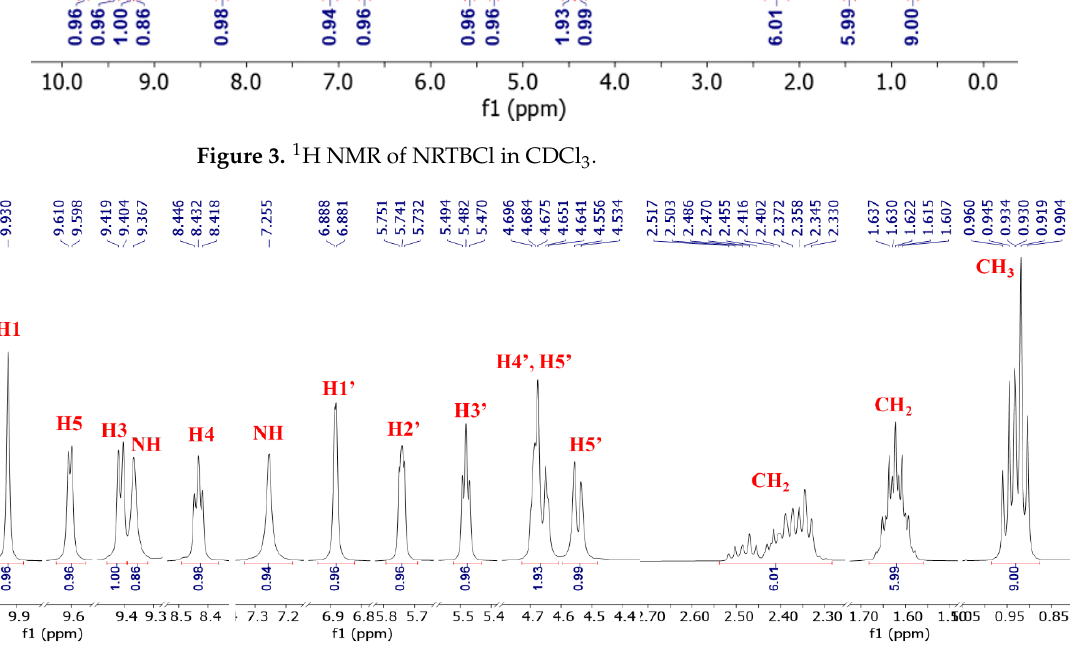
Figure 4. Expanded 1 H NMR of NRTBCl.